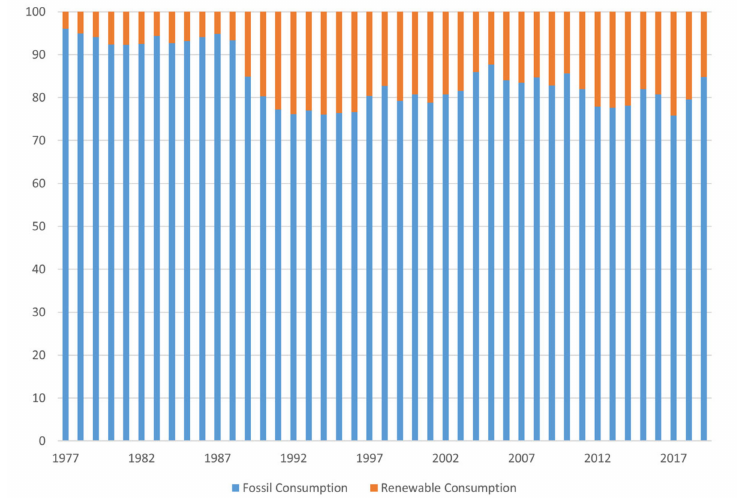
Figure A4. The ratio of total energy consumption in Vietnam, 1977–2019.